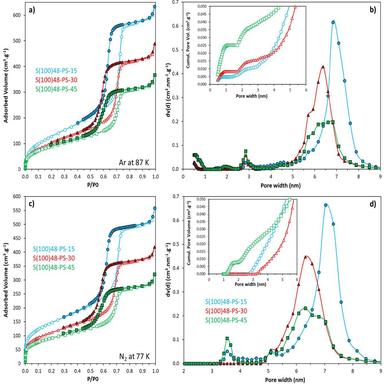
Ar at 186 C and N2 at 196 C physisorption isotherms (a, c) and corresponding NLDFT desorption pore size distributions (b, d) of S(100)48-PS composite materials. Magnified NLDFT cumulative pore volume curves, calculated from the adsorption branches, are presented in insets.